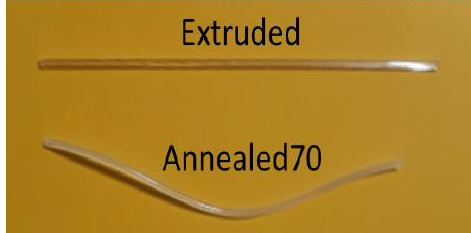
Figure 4. Image of Extruded and Annealed70 tubing, highlighting the level of curvature in the tube post-annealing.